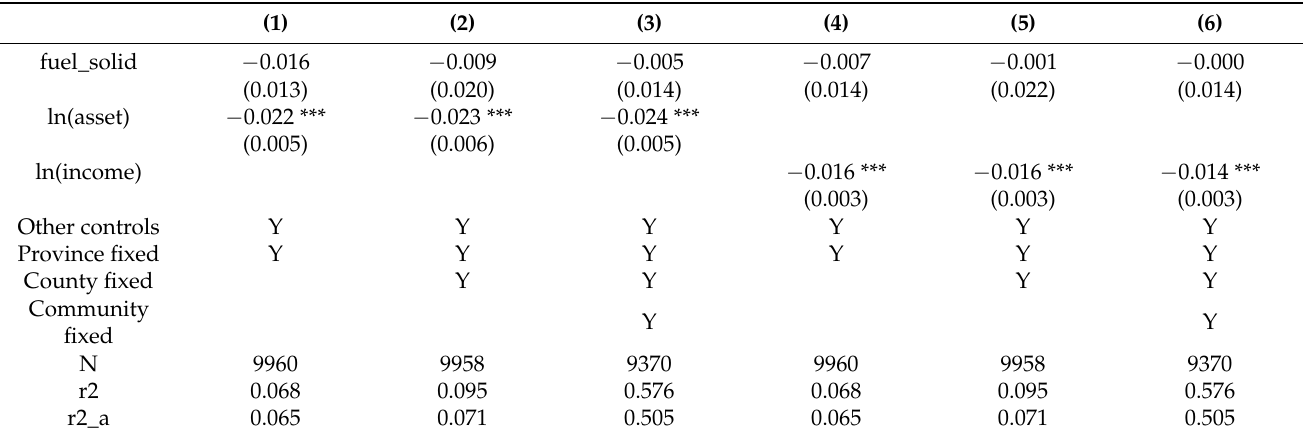
Table 6. Effects of solid cooking fuels on fuel fees.